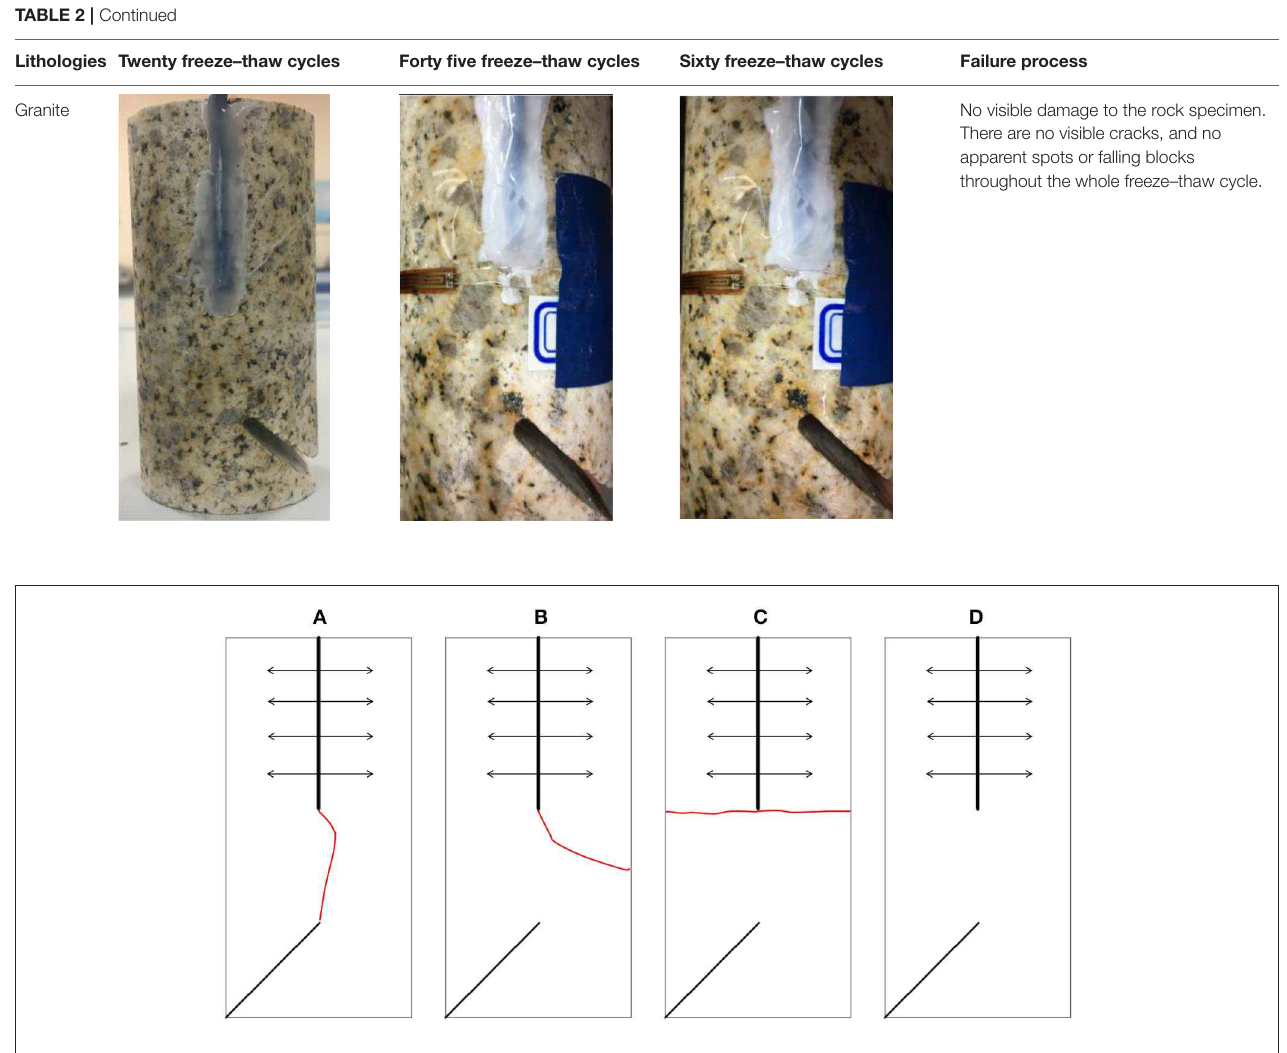
FIGURE 3 | Freezing–thawing failure characteristics of specimens. (A) Red Sandstone. (B) Limestone. (C) Killas. (D)